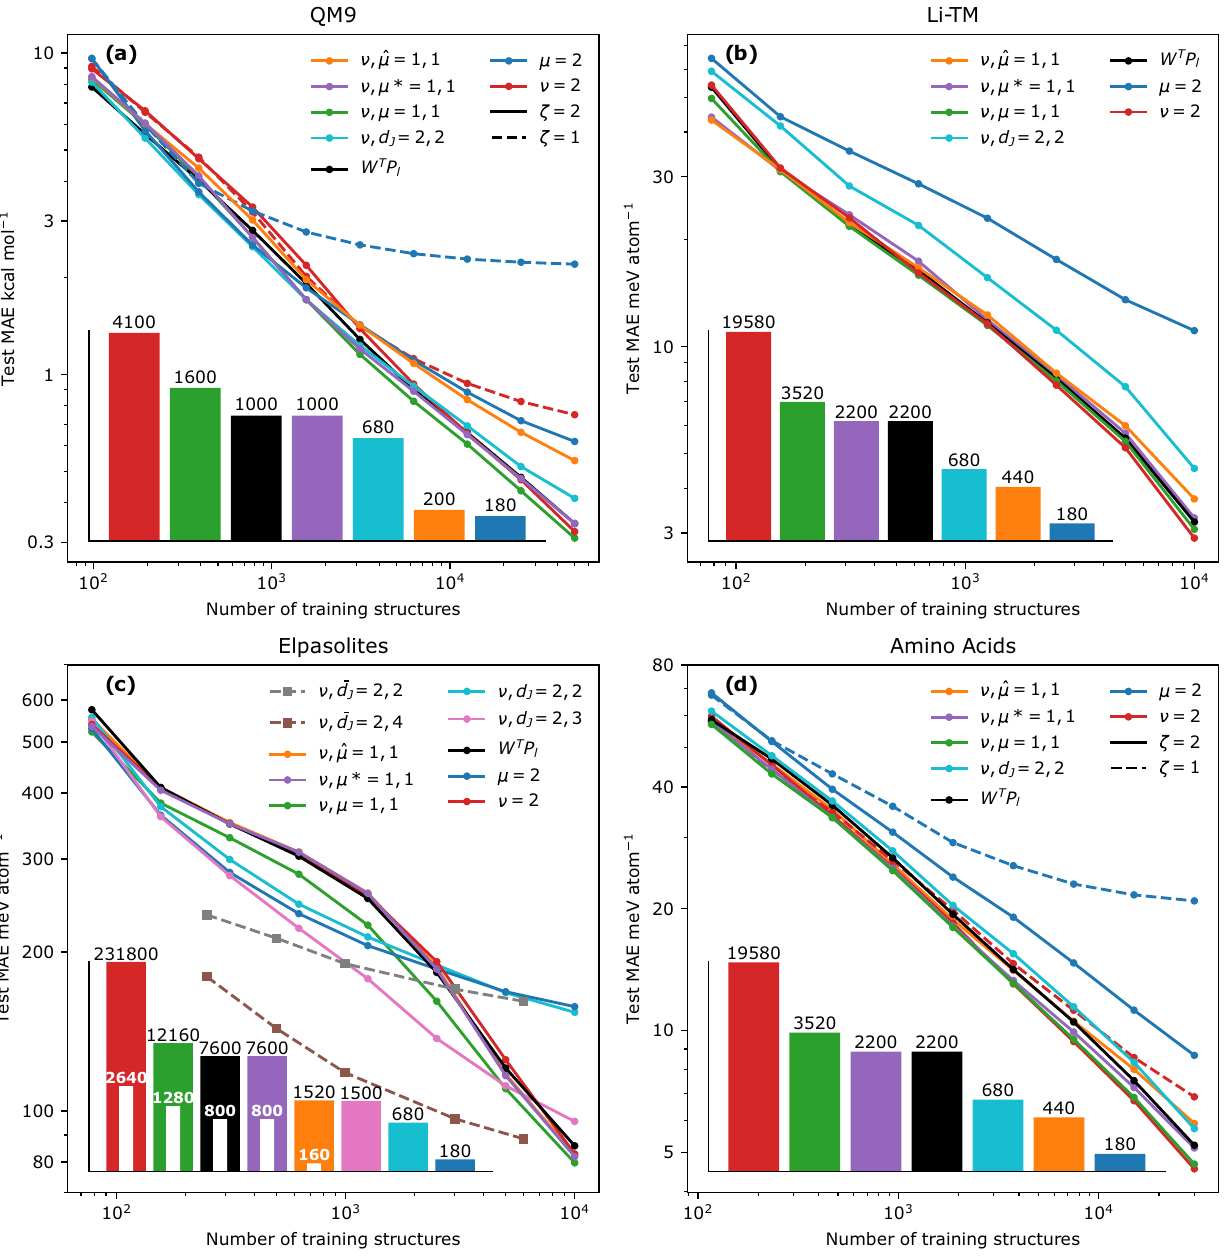
Fig. 7 Learning curves for the total energy fi ts. For the Li-TM dataset ζ = 1, 2, 4 and 8 were all tested but only the models with ζ = 8 are shown. The d J ¼ 2 and d J ¼ 4 curves for the Elpasolites are taken from ref. 21 where the embedding was optimised. All models for the Elpasolites were fi tted using ζ = 1. The total length of the descriptors is indicated in the bar chart. The overlaid white bars indicate the number of non-zero elements present, computed using S env =